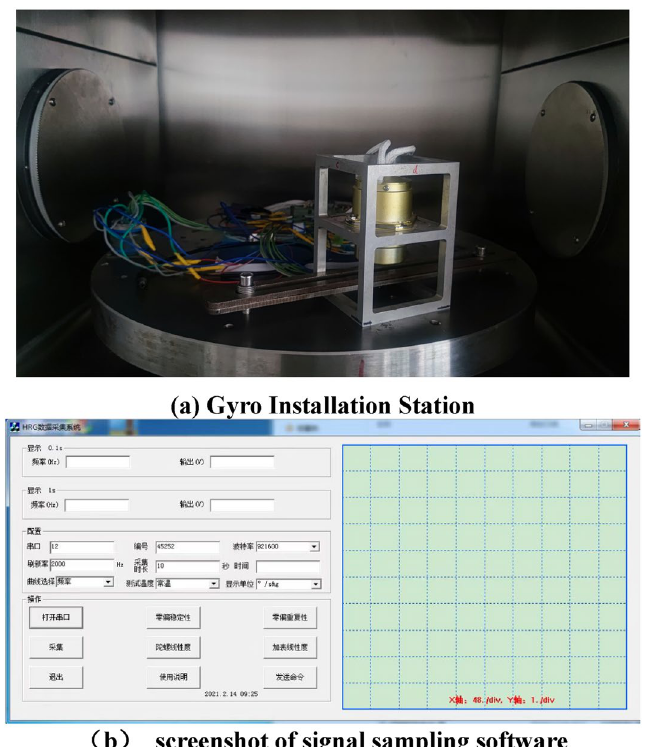
Figure 2. Photos of the